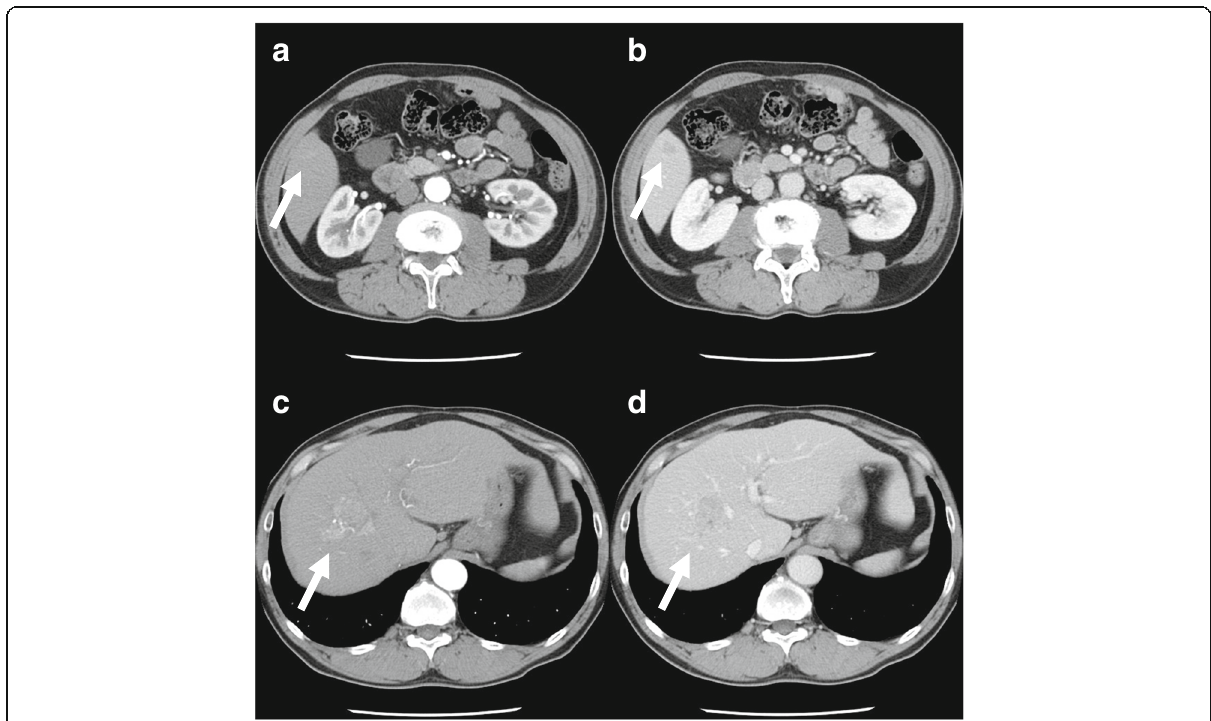
Fig. 1 Dynamic CT findings before surgery. Dynamic CT revealed two tumors (arrows) located in a , b segment 8 and c , d segment 5. a , c Findings in the early phase. b , d Findings in the delayed phase